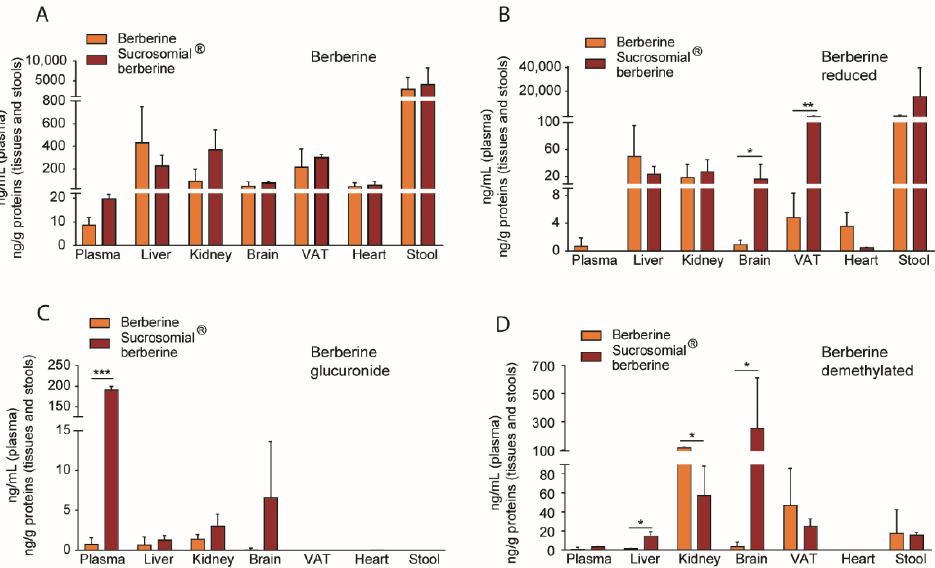
Figure 4. Distribution of berberine and its metabolites after oral administration of Sucrosomial ® berberine (6.25 mg/Kg) and berberine (50 mg/Kg). The Sucrosomial ® formulation triggers a differential berberine biodistribution among the analyzed tissues ( A ), as well as a differential biodistribution of the berberine metabolites such as the berberine reduced form ( B ), the berberine glucuronide ( C ), and the demethylated berberine product ( D ). VAT: visceral adipose tissue. * p < 0.05, ** p < 0.01, *** p < 0.001.